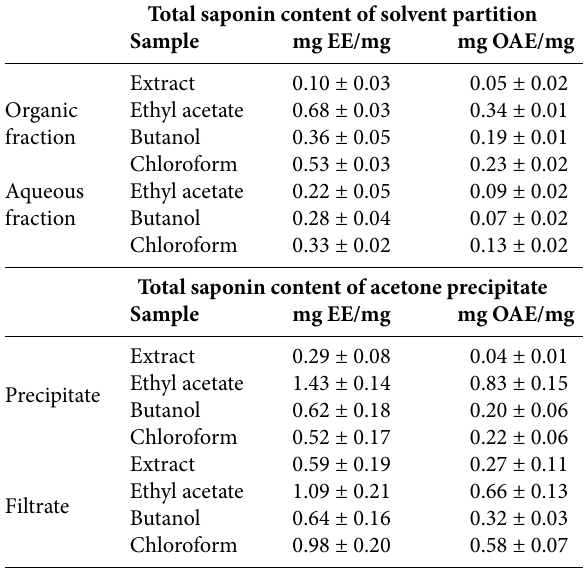
Table 2 . Total saponin content of organic fractions and their aque- ous counterparts after solvent partition, and precipitates and its fil- trates after acetone precipitation Total saponin content of solvent partition